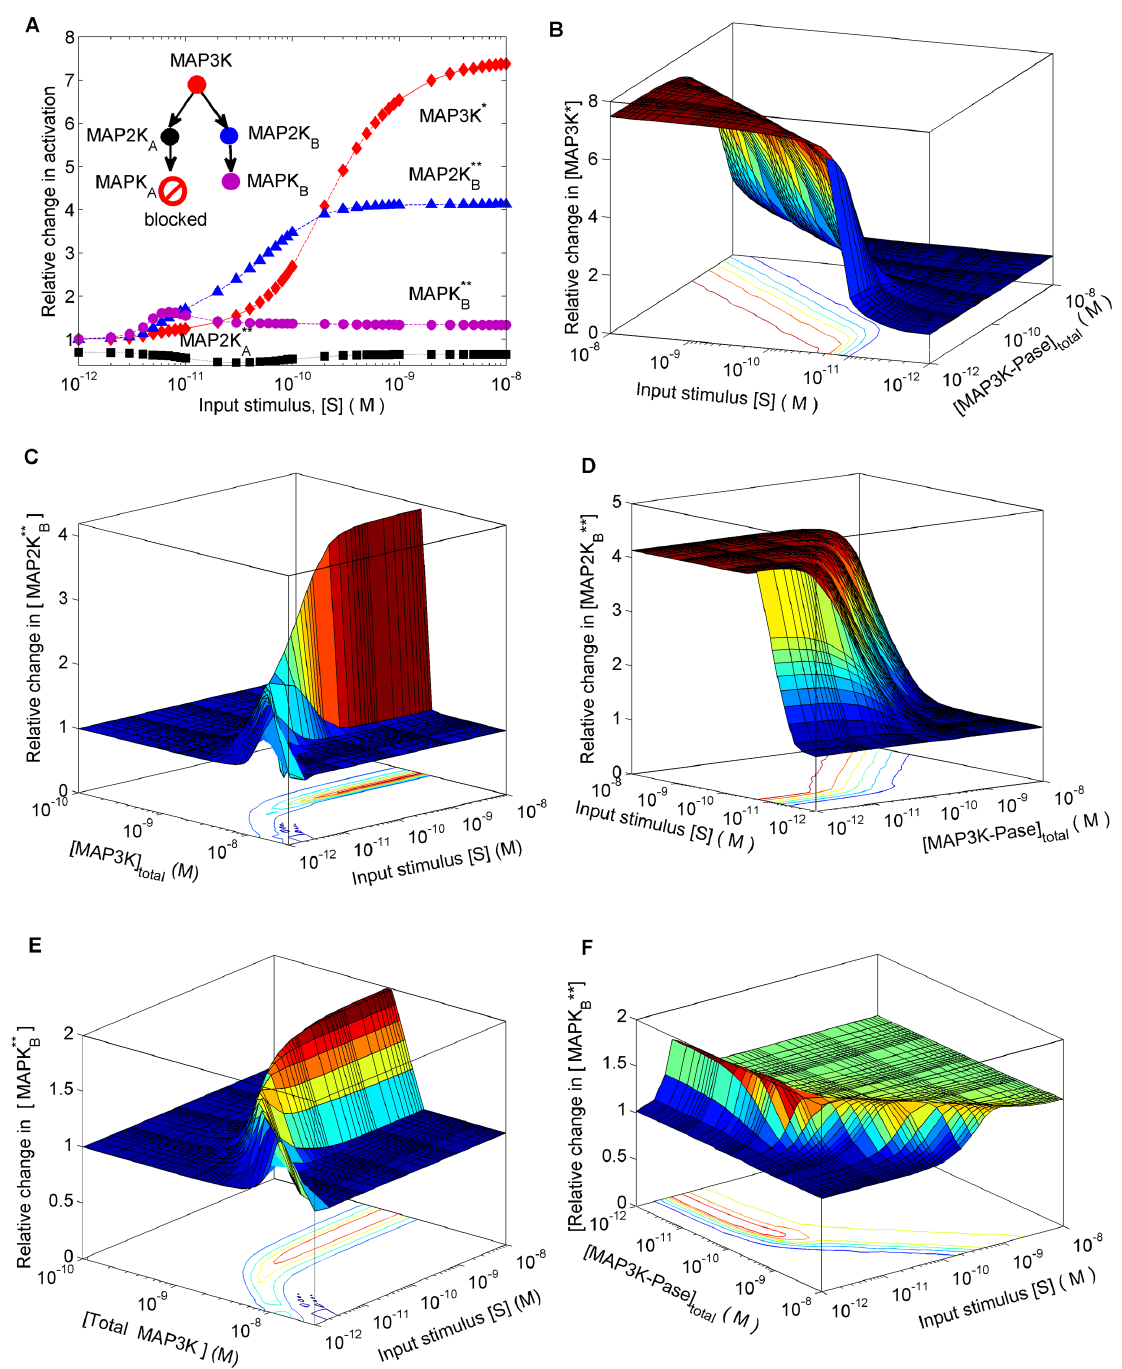
Figure 3. Amplification of response in unperturbed branch through retrograde propagation of information in a branched motif. (A) Relative change in the response of different molecular species in branches A and B as a function of signal strength, when phosphorylation of terminal kinase MAPK A in branch A is inhibited. Inset shows a schematic diagram of the branches, with the ‘‘stop’’ sign indicating blocking of activation of MAPK in branch A. (B–F) The perturbation results in amplification (relative to the unperturbed condition) of the concentrations of (B) MAP3K* (D) and (F) MAPK (cid:1)(cid:1) , shown as a function of signal strength and concentration of the phosphatase MAP3K-Pase. Relative increase in MAP2K (cid:1)(cid:1) B B and (E) MAPK (cid:1)(cid:1) as a result of the perturbation are also shown as a function of signal strength and the total concentrations of (C) MAP2K (cid:1)(cid:1) B B concentration of MAP3K. doi:10.1371/journal.pone.0064409.g003 binding site enhances the phosphorylation of MAPK B (Table 1). that the observed modulation of phosphorylation amplitudes of As there is no experimental evidence of explicit feedback JNK and p38MAPK emerges as a result of long-range coordina- regulation between JNK and p38MAPK, it is extremely likely tion through retrograde information propagation. The experi-